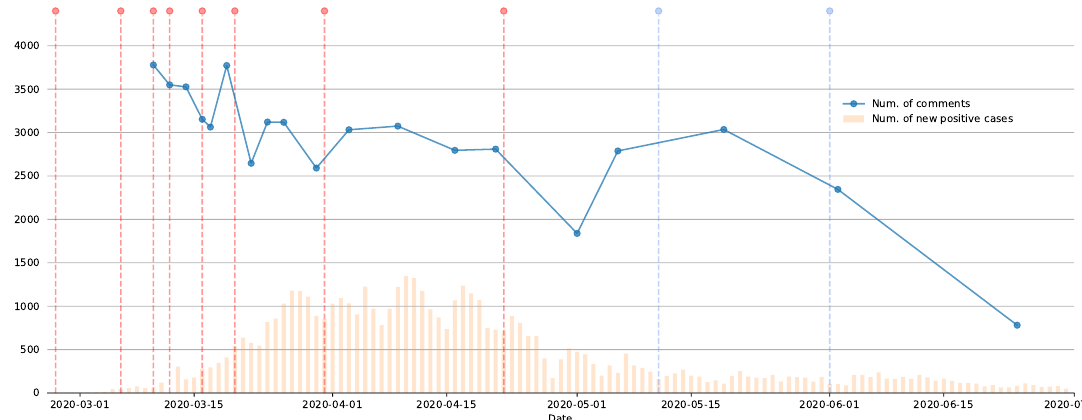
Figure 6. Number of comments per megathread in /r/de compared to the number of new daily cases in Germany. Vertical lines represent adopted critical events and policies.